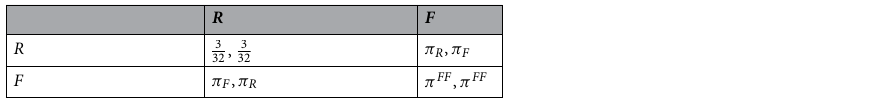
612 α 4 + 924 α 3 + 441 α 2 + 86 α + 6 16 (α + 1 )( 4 α + 1 )( 9 α + 2 ) 2 , π F